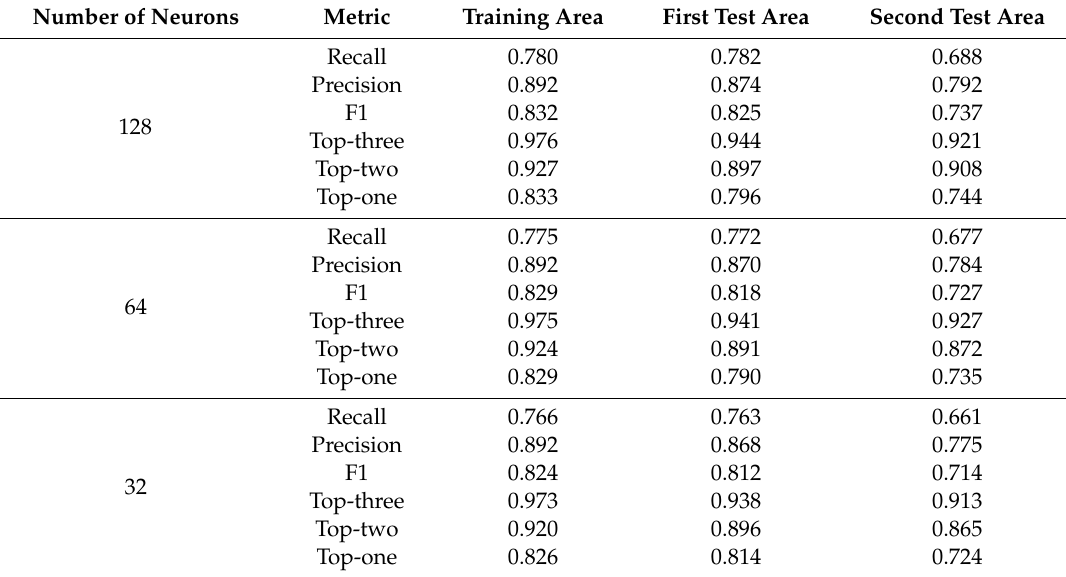
Table 10. Impact of the number of neurons on the CNN-2 network.